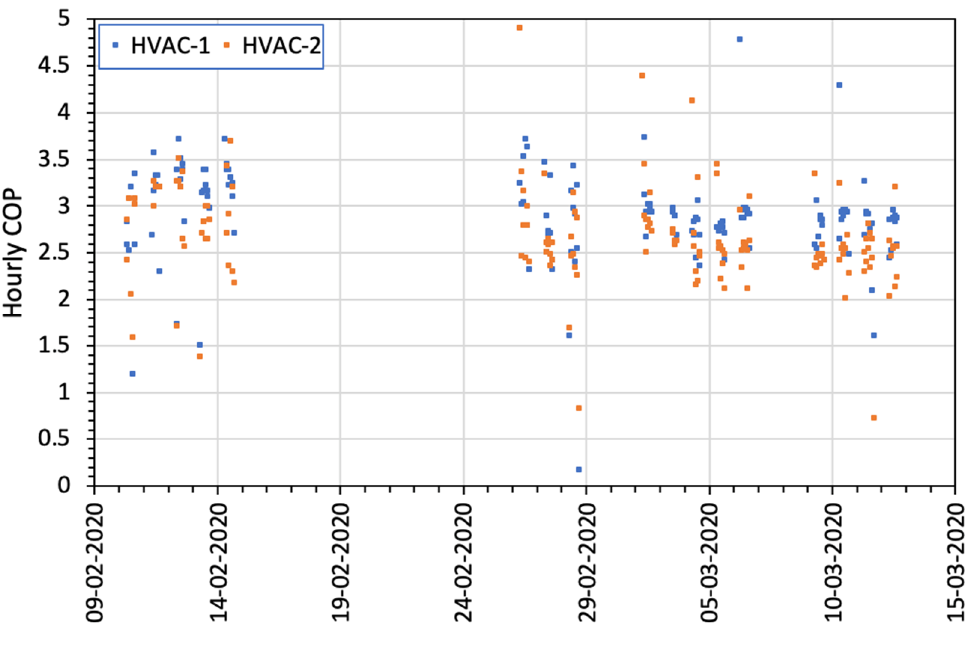
Figure 5. Hourly COP comparison between HVAC-1 and HVAC-2 (10 February 2020–9 March 2020).